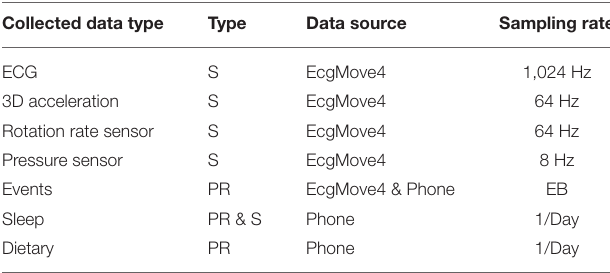
TABLE 2 | Specifications of the collected data. S, sensed; PR, patient-reported; EB, event-based. Collected data